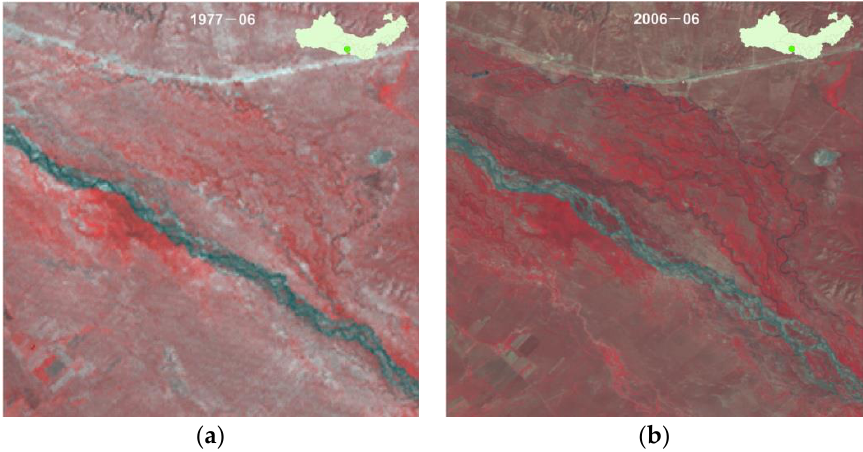
Figure 9. The significant positive changes of vegetation production by human activities in northeast of Qinghai Province: ( a ) MSS image in June 1977; and ( b ) TM image in June 2006. ISPRS Int. J. Geo-Inf. 2016 , 5 , 158